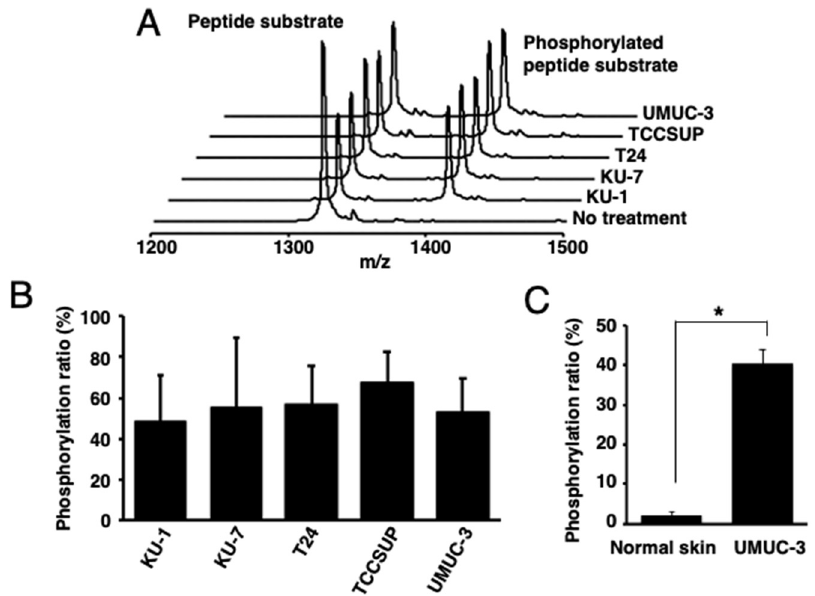
Figure 2. Identification of activated PKC α in human bladder cancer cells. ( A ) The MALDI-TOF MS spectra and ( B ) phosphorylation ratios after the phosphorylation of a PKC α -specific peptide by the lysates of five human bladder cancer cell lines. ( C ) Phosphorylation ratios after the phosphorylation of a PKC α -specific peptide substrate with the lysate from cancer cell (UMUC-3)-bearing mouse tissues or normal mouse tissues (n = 3). * p < 0.01.